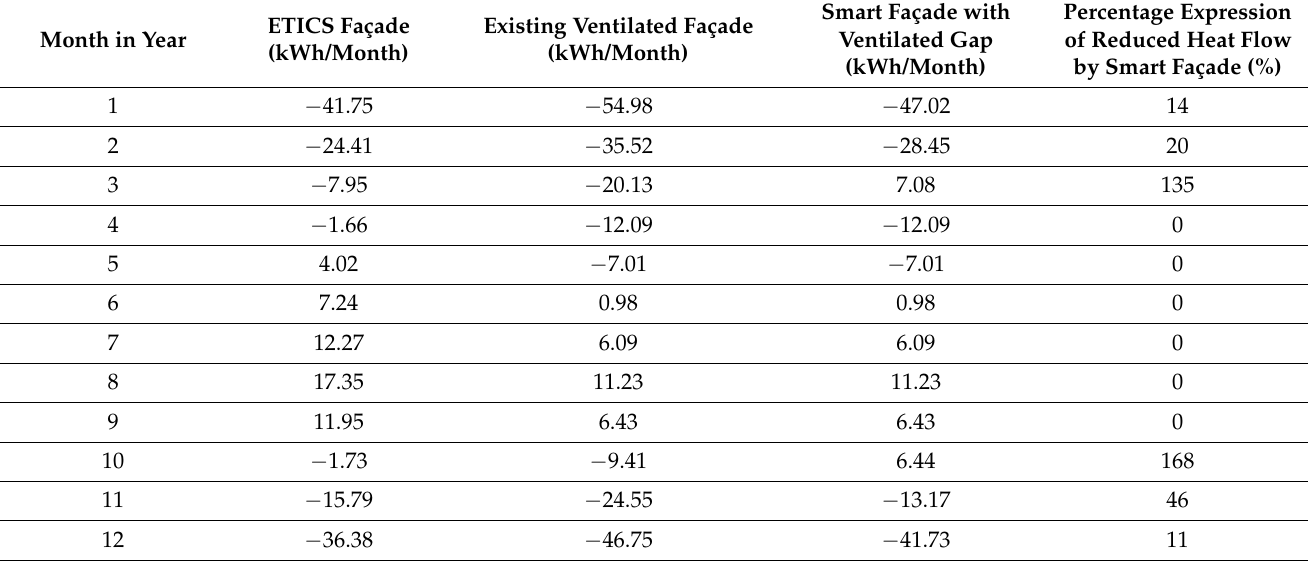
Table 5. Comparison of calculated total values of heat flows for the façade type in